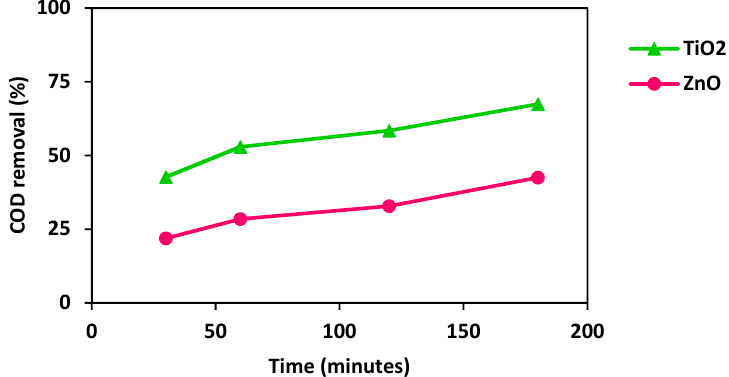
Figure 5. Effect of type of catalyst on photocatalytic degradation (process conditions: pH—4, reaction time—3 h, UV light irradiation—64 W, catalyst dosage—500 mg/L).